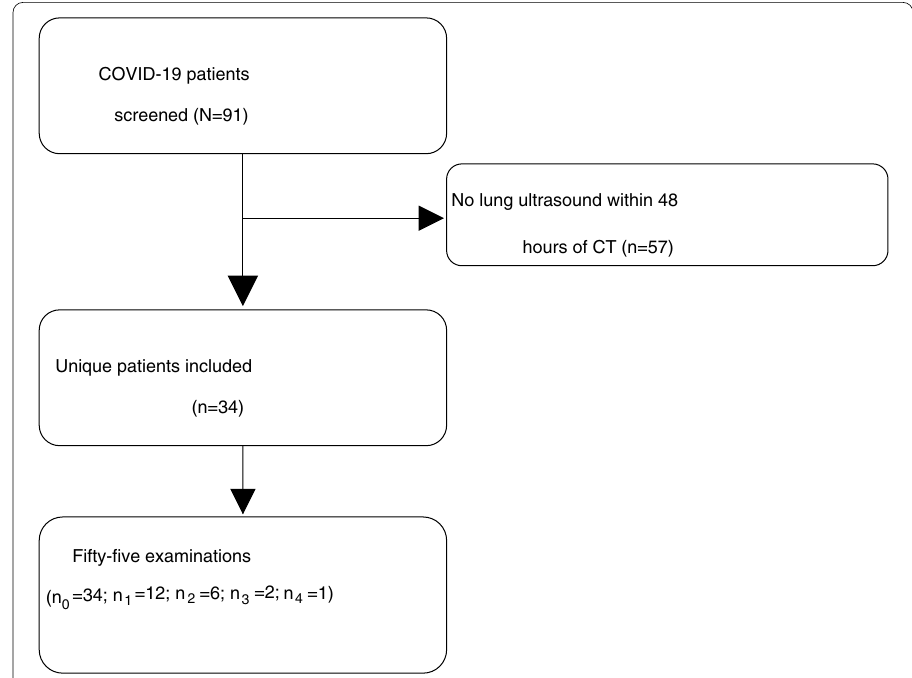
Fig. 1 Flowchart of COVID‑19 patient screening and inclusion. Legend: n 0 refers to the amount of baseline examinations. n 1 , n 2 , etc., refers to second examination, third examination, etc.,